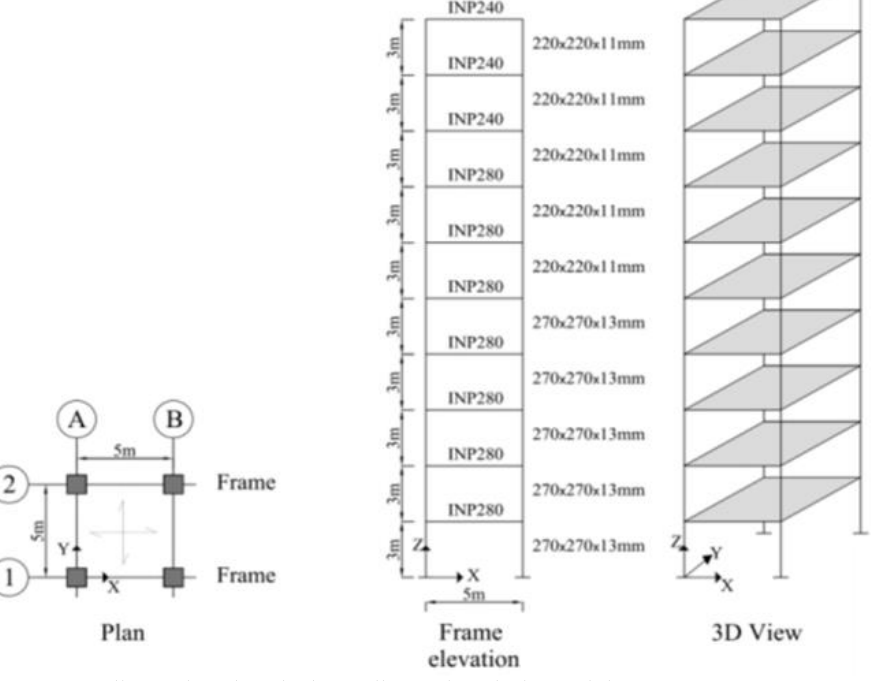
Fig. 1. Two-dimensional and Three-dimensional view of the 10-storey Structure [7].